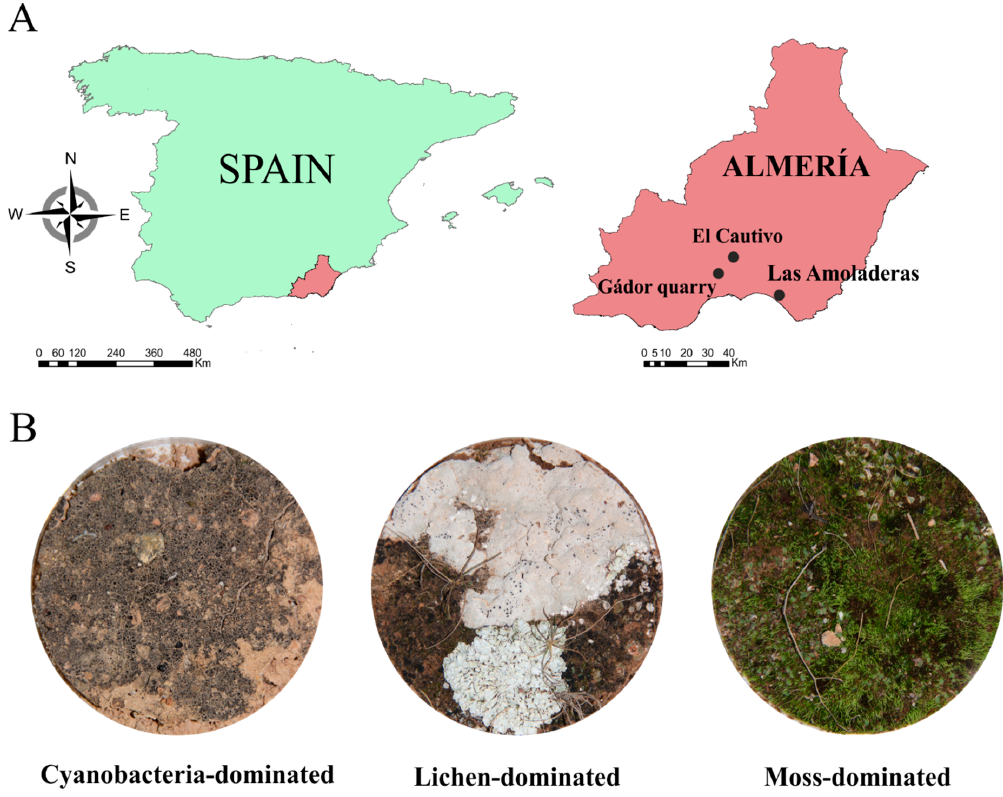
Figure 1. ( A ) Study area location. ( B ) Exemplars of different natural biocrust types found in the study zones: cyanobacteria-dominated, lichen-dominated, and moss-dominated biocrusts. At the same experimental areas, soil substrates were collected at a 2 cm depth, air-dried, and sieved to 2 mm in order to remove the small herbs and rock fragments. Three native filamentous (L.) Kunth ( = Stipa tenacissima L.) and sandy loam soils with a 10YR 4 / 6 color (dry). Most of the nitrogen-fixing cyanobacteria species, Nostoc commune (CANT2 UAM 817), Scytonema hyalinum (CAU6 UAM 820), and Tolypothrix distorta (CANT7 UAM 825) that had been previously isolated